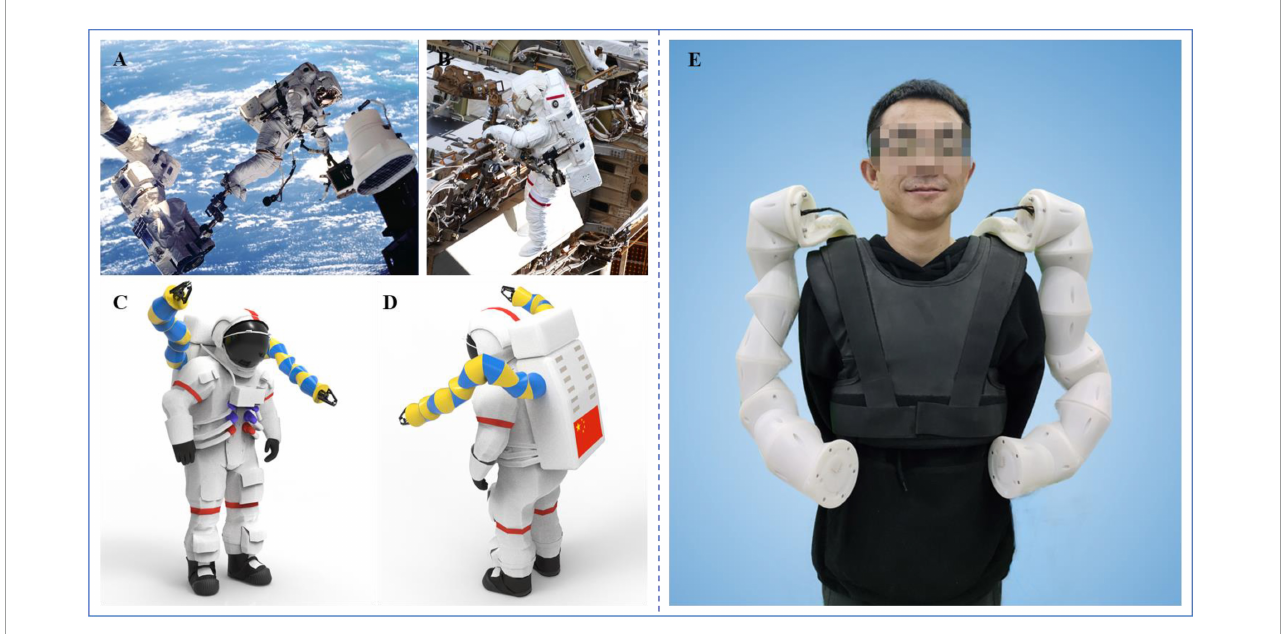
FIGURE1 Wearable robotic limbs for astronauts. (A) Performing EVA with the help of the space station’s robotic arm (Mohon, 2014). (B) Performing EVA without the space station’s robotic arm (Garcia, 2019). (C) The rendered view of the front side of the wearable robotic limbs for astronauts. (D) The rendered view of the back side of the wearable robotic limbs for astronauts. (E) Wearing display of the robotic limbs for